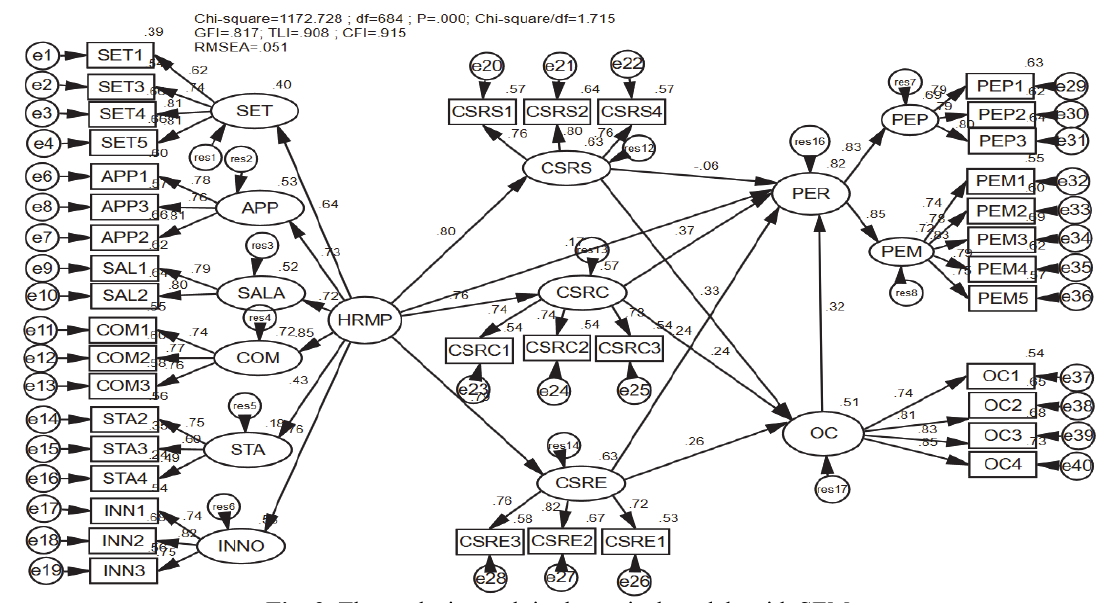
Fig. 3. The analysis result in theoretical models with SEM Source: Authors’